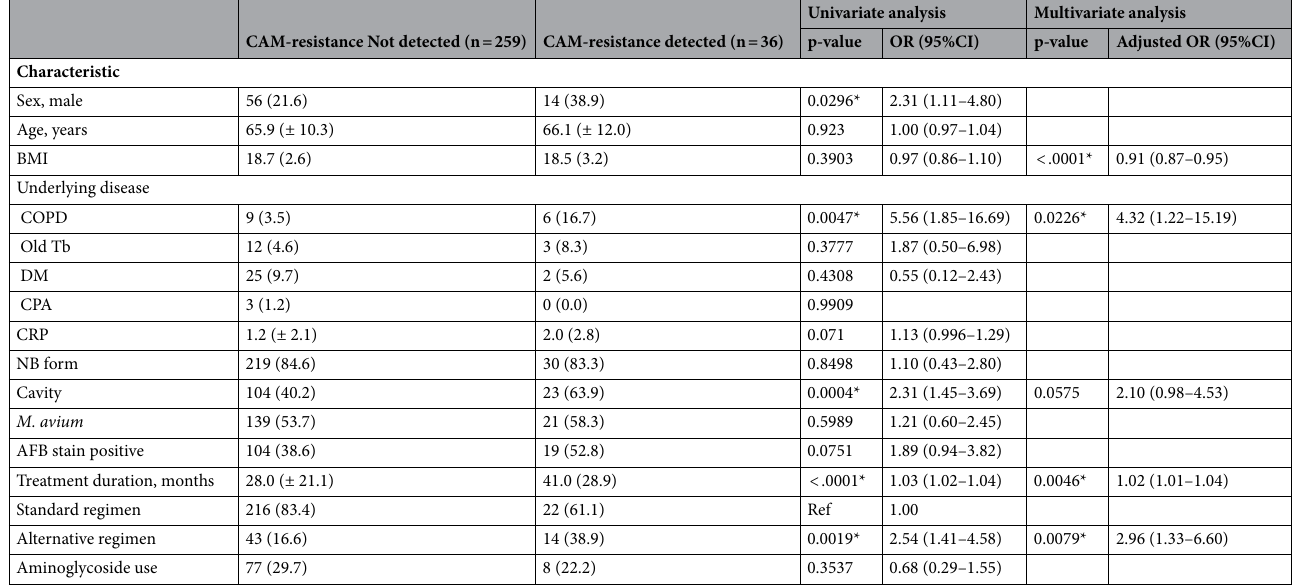
Table 3. Risk factors for development of CAM resistance in MAC-PD patients. Data represent n (%) or median (interquartile range). Drug susceptibility tests were re-examined after treatment initiation in 53.4% (127/238) of patients receiving standard regimens and 62.5% (35/57) of patients receiving alternative regimens. MAC-PD Mycobacterium avium complex pulmonary disease; OR odds ratio; CI confidence interval; BMI body mass index; COPD chronic obstructive pulmonary disease; Tb tuberculosis; DM diabetes mellitus; CRP C-reactive protein; NB nodular bronchiectasis; CAM clarithromycin.